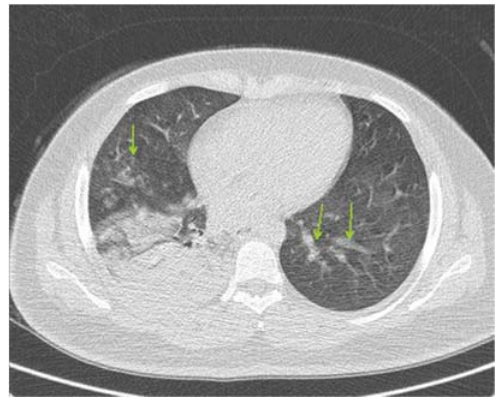
Figure 1. Lung involvement on the first day.